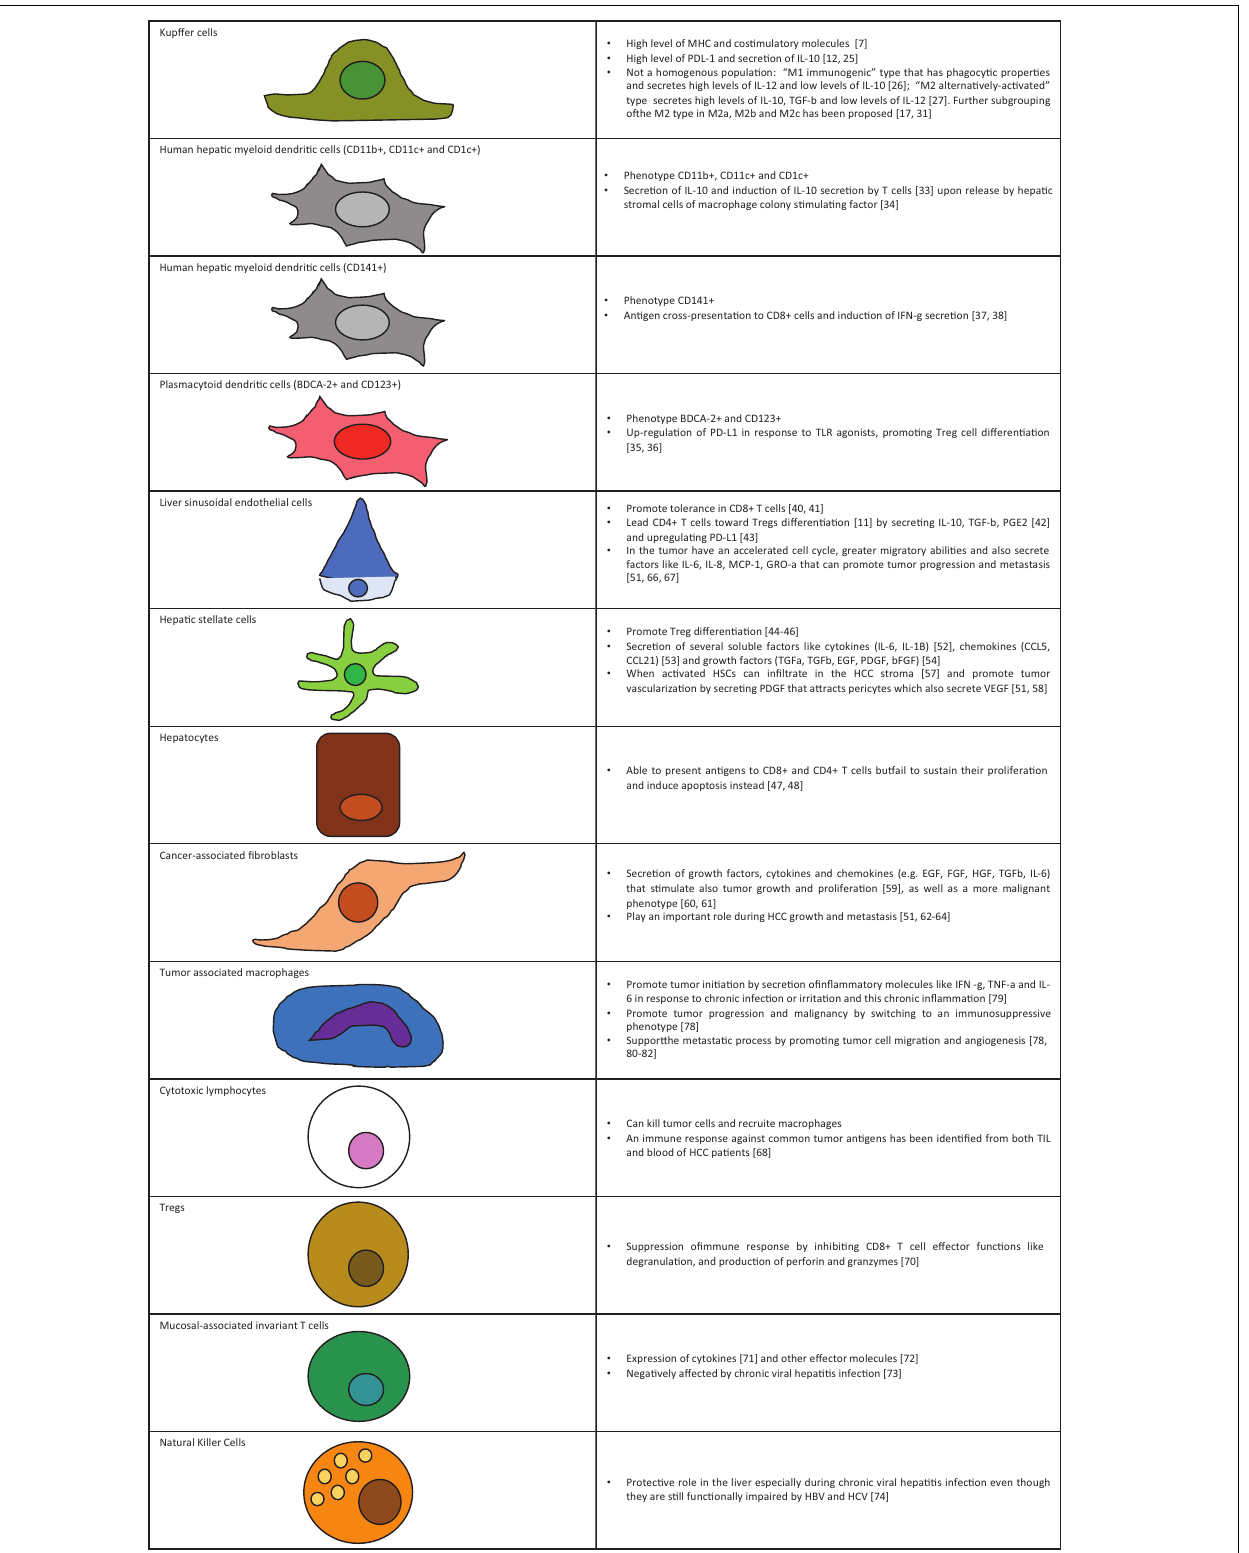
Frontiers in Immunology |